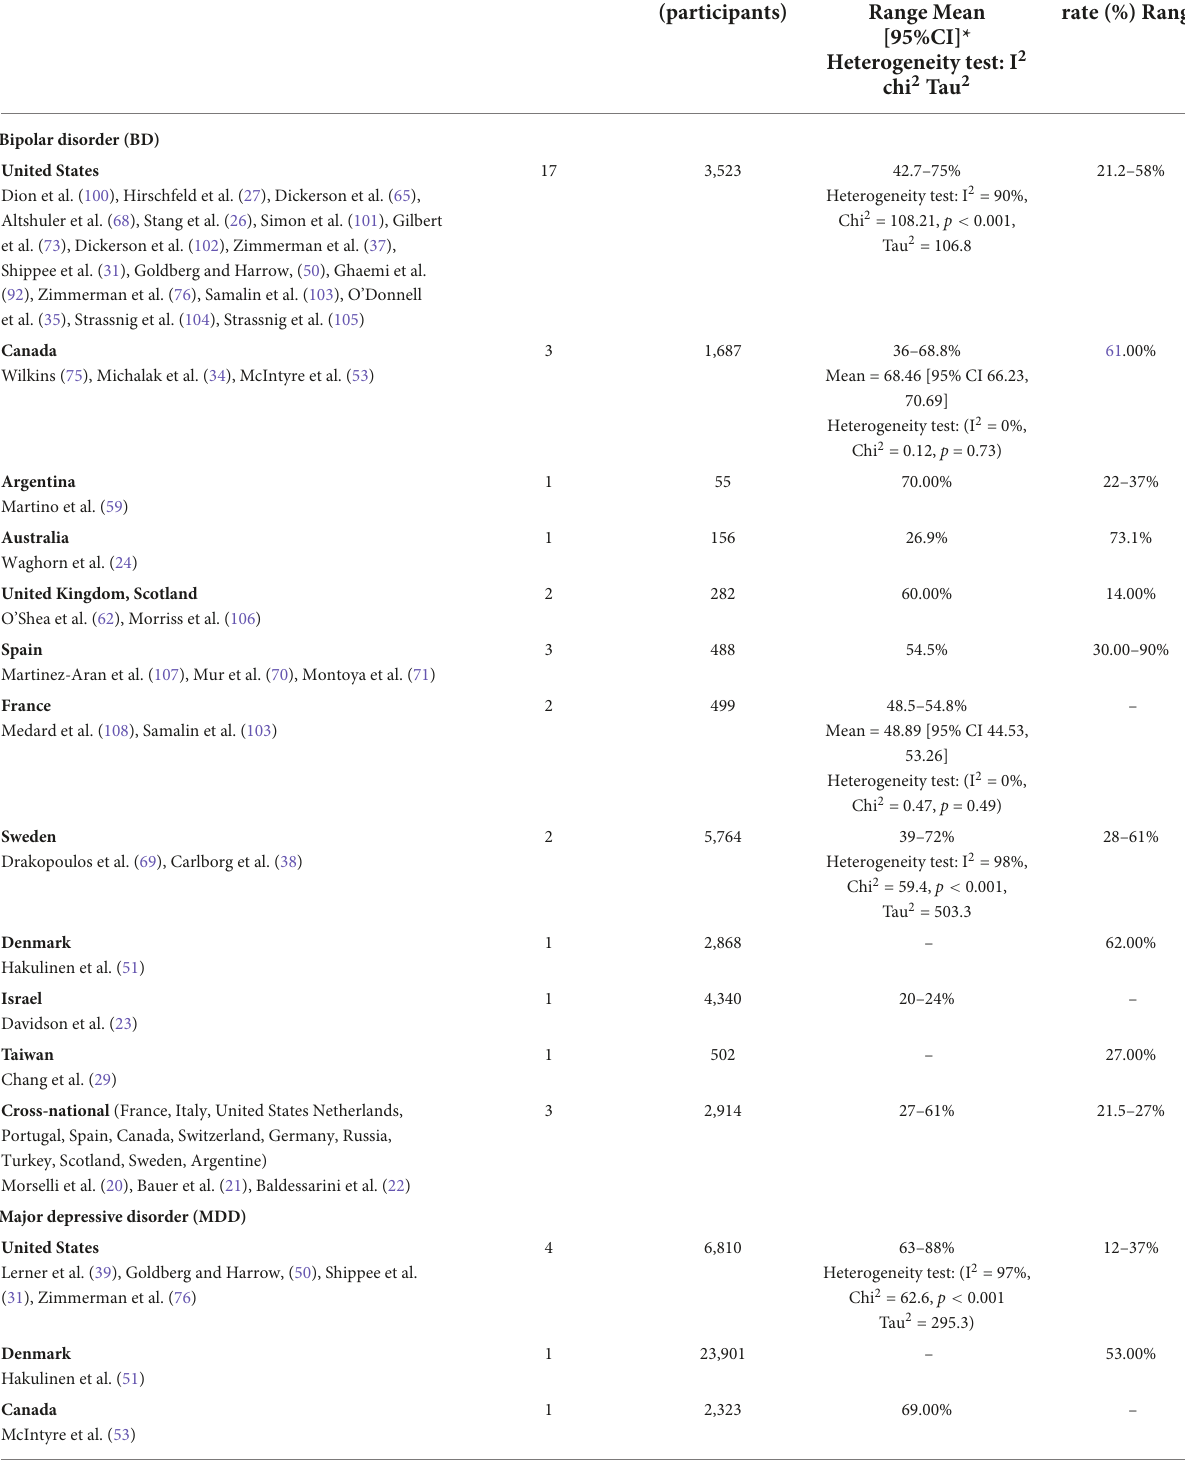
TABLE 1 Employment and unemployment rates in bipolar spectrum disorders by country.